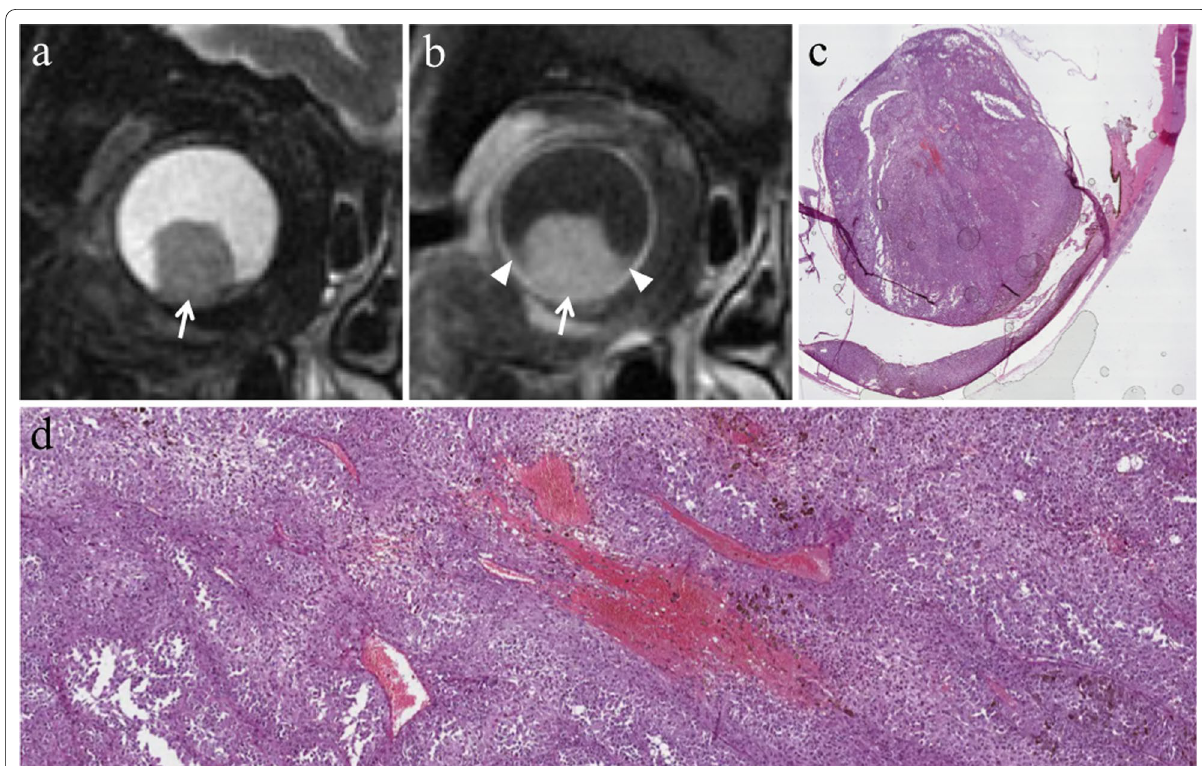
Fig. 8 A 79-year-old woman with a poorly pigmented choroidal melanoma and hemorrhagic retinal detachment of the right eye. Coronal ( a ) T2-weighted turbo spin-echo STIR and ( b ) contrast-enhanced fat-suppressed T1-weighted images show a dome-shaped intraocular lesion along the inferior aspect of globe (white arrows), exhibiting intermediate signal intensity on T2-weighted image and enhancement on contrast-enhanced T1-weighted image. Note the small non-enhancing retinal detachment on both sides of the mass (white arrowheads in b ). ( c ) Histological examination: the radiologically described mass on the posterior wall of the eye is well evident on low magnification; melanoma cells appear poorly pigmented (H&E, original